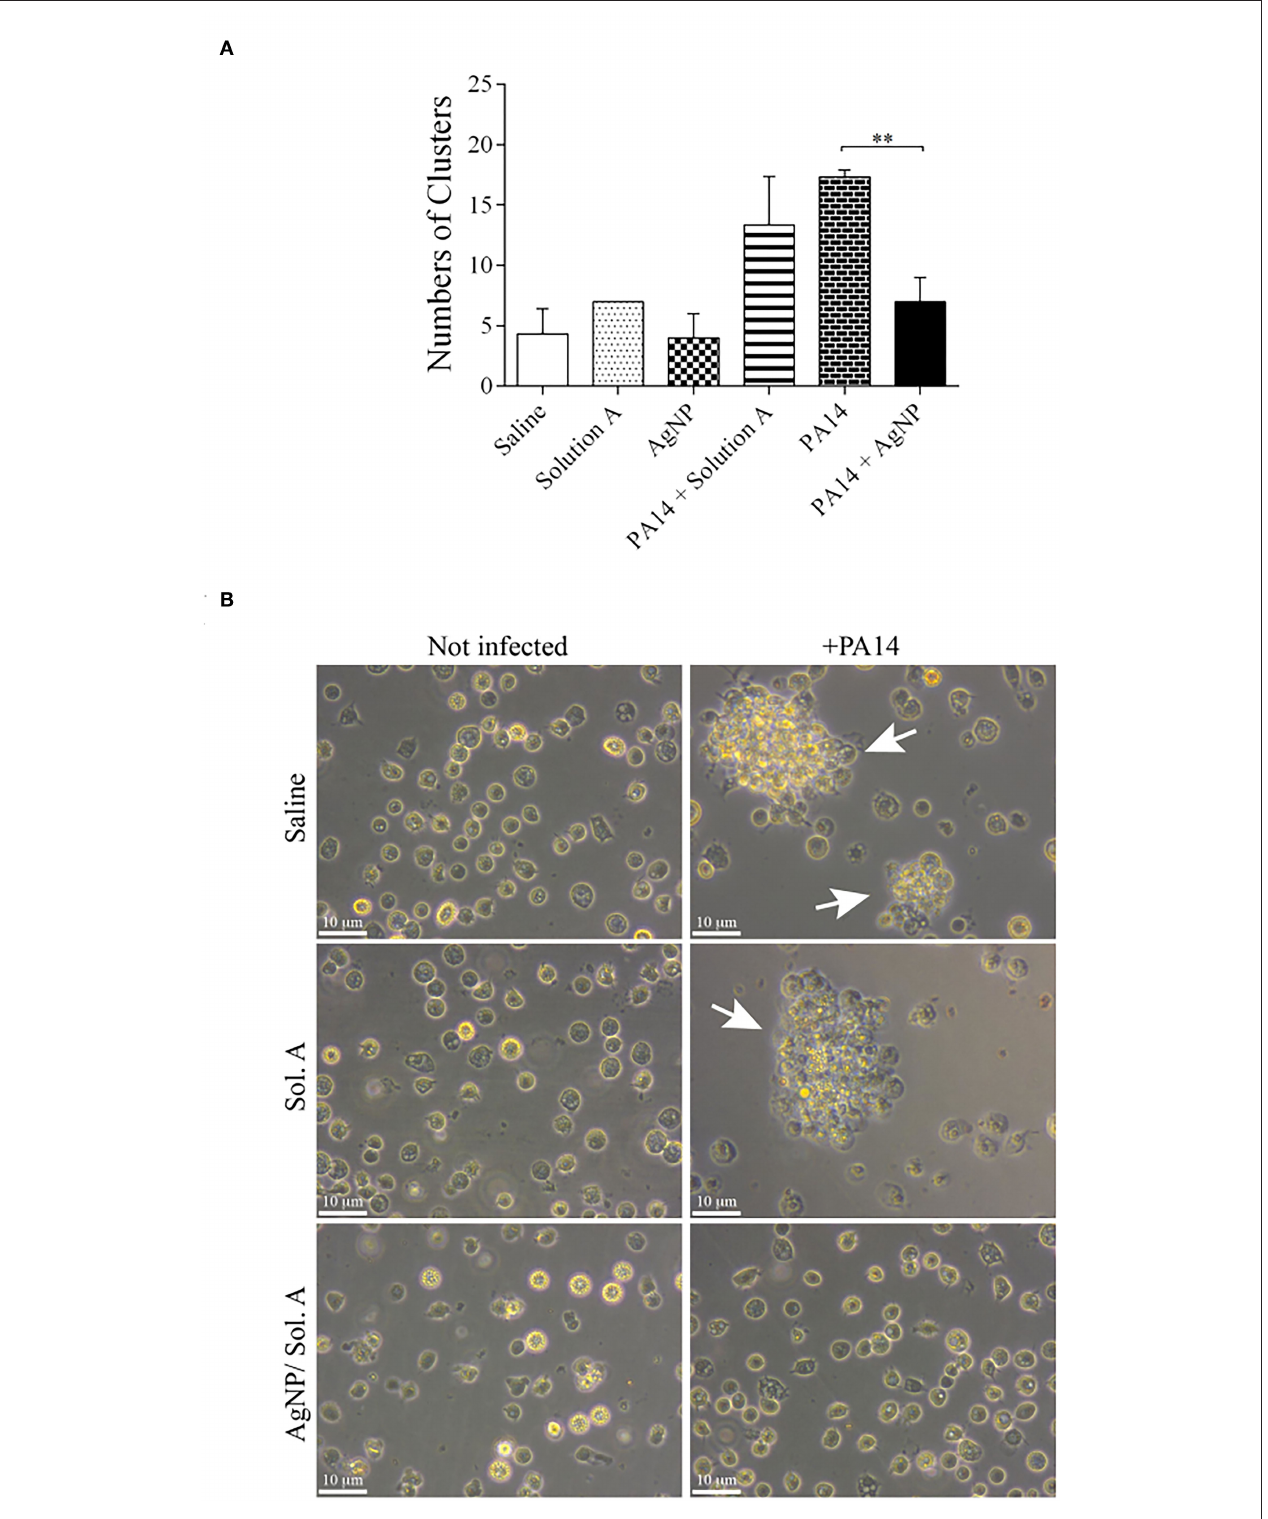
FIGURE 7 | (A) Quantification of cell clusters during the nodulation process. The number of clusters was determined by counting cell aggregates (nodulation) under a light microscope. The bars representations are as described in the legend of Figure 4 . Each bar represents the mean and standard deviations of three independent experiments. Each treatment condition contained 16 larvae . ** p = 0.0010 (ANOVA and RM ANOVA followed by t -test). (B) Representative microscope images of cell nodulation. Micrographs on the left show hemocytes extracted from non-infected larvae and micrographs on the right show hemocytes from larvae treated with PA14 bacteria. White arrows indicate aggregates of